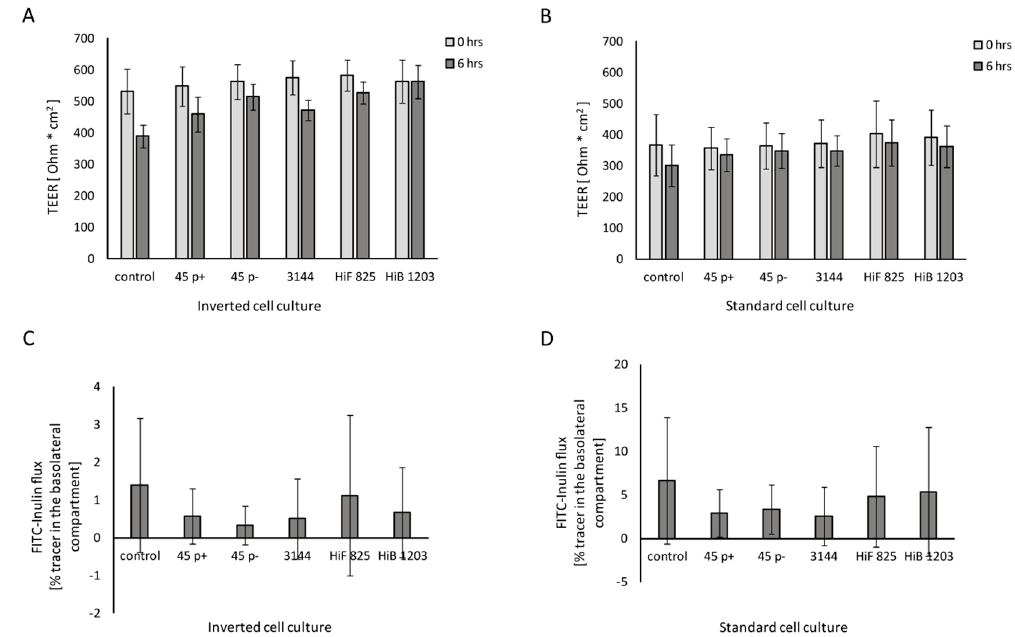
Figure 2. Barrier integrity of HIBCPP cells infected with the indicated NTHI, HiF and HiB isolates 0 h, black bars). TEER values of cells cultured in: ( A ) the inverted cell culture system; and ( B ) the standard cell culture system at the time of infection (time point 0 h, grey bars) and at the end of infection (time point 6 h, black bars). Percentage of FITC-labeled inulin flux of HIBCPP cells grown in: ( C ) the inverted cell culture system; and ( D ) the standard culture system. Infection was carried out for 6 h, and uninfected control cells were analyzed in parallel. The FITC-inulin flux was measured in apical-to-basolateral direction and is expressed as percentage of tracer in the basolateral